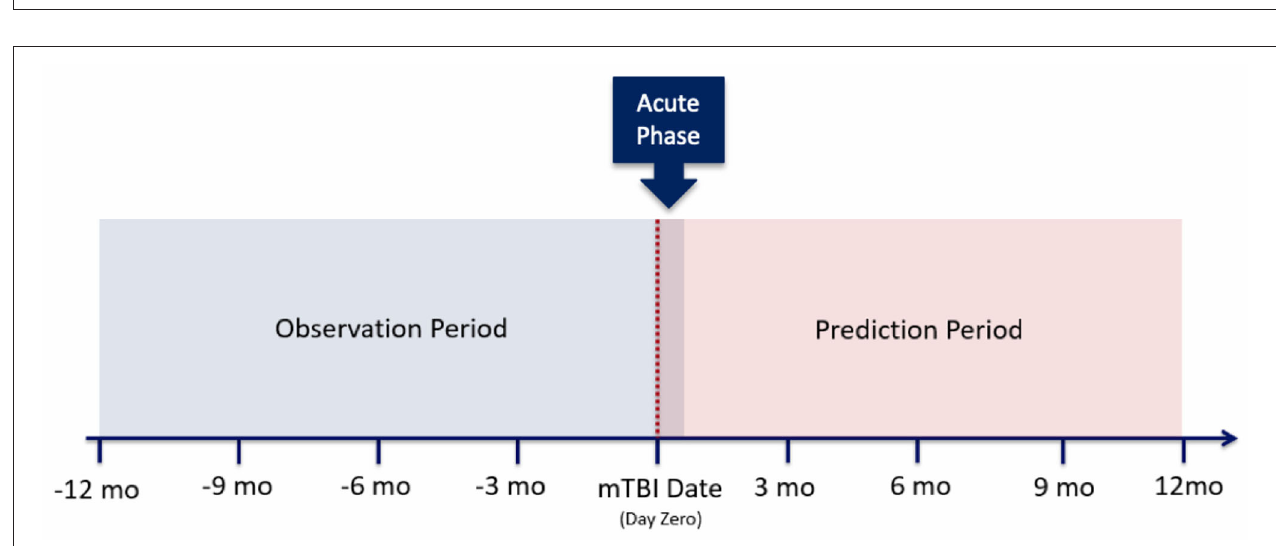
FIGURE 2 | Different window configurations for the observation period.